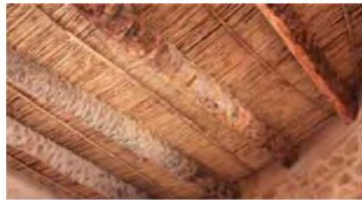
Figure 3. Palm Trunk Beams used for traditional roofing in Sinai (Ibrahim, 2010)